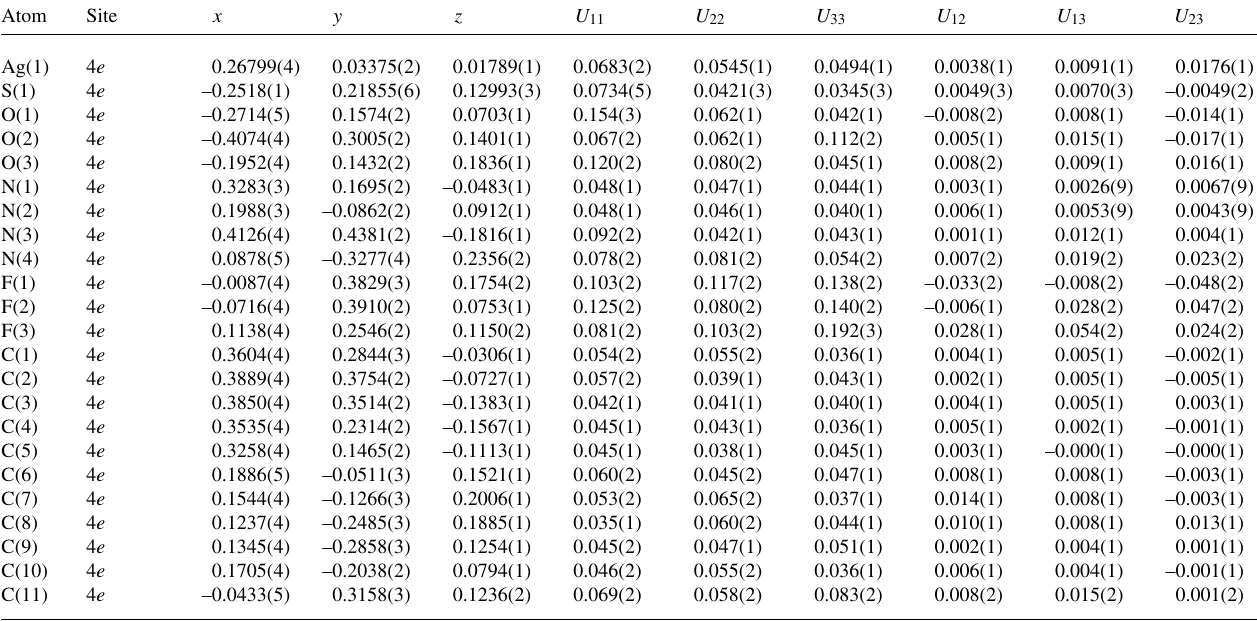
Table 3. Atomic coordinates and displacement parameters (in Å 2 )